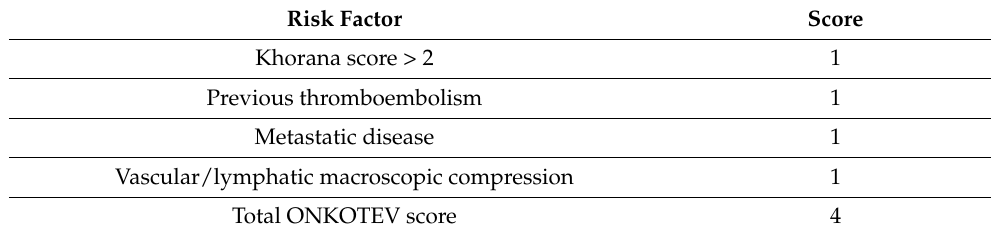
Table 5. ONKOTEV VTE risk score